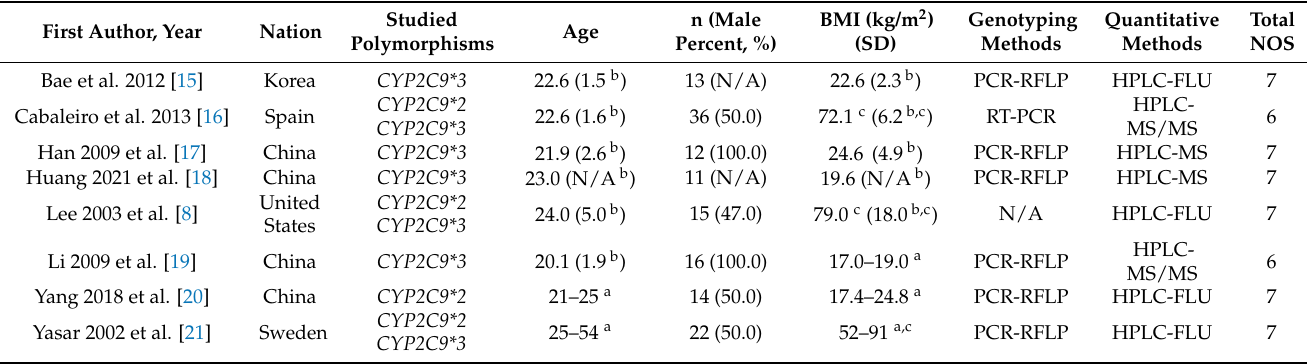
Table 1. Characteristics of studies included.